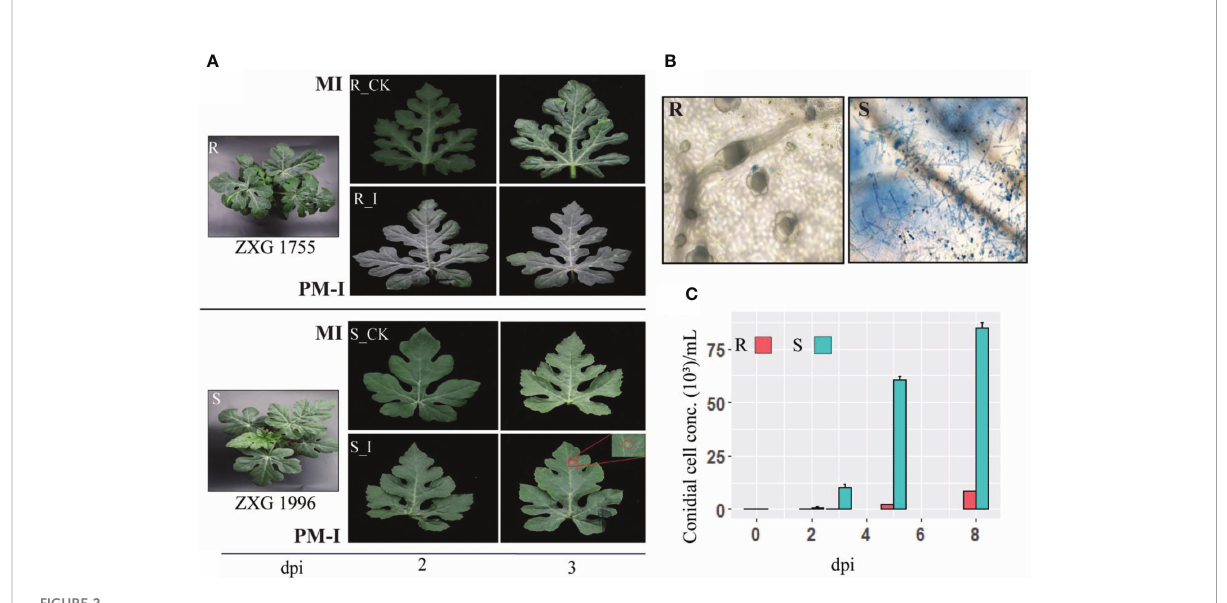
FIGURE 2 Interaction phenotypes of P. xanthii race ‘ 2F ’ among mock and disease inoculated leaves of watermelon resistant and sensitive lines after 48(h). (A) Phenotypes of mock-inoculated (MI) and powdery mildew inoculated (PM-I) in resistant (R_CK/I) and susceptible (S_CK/I) cultivars of watermelon. (B) Post-invasion response and hyphal growth in different contrasting cultivars after post inoculations. P. xanthii race ‘ 2F ’ hyphae were stained with trypan blue. (C) Bar graph depicting the number of PM conidials on the leaves of ZXG 1755/1996 lines on MI, PM-I, and at 5 and 9